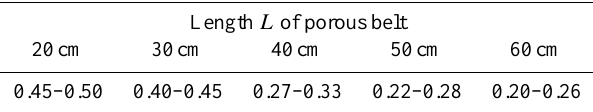
Table 2. Wave transmission coefficient for several lengths of porous medium, calculated using conductivity K 1 = 0 . 7, K 2 =0.75